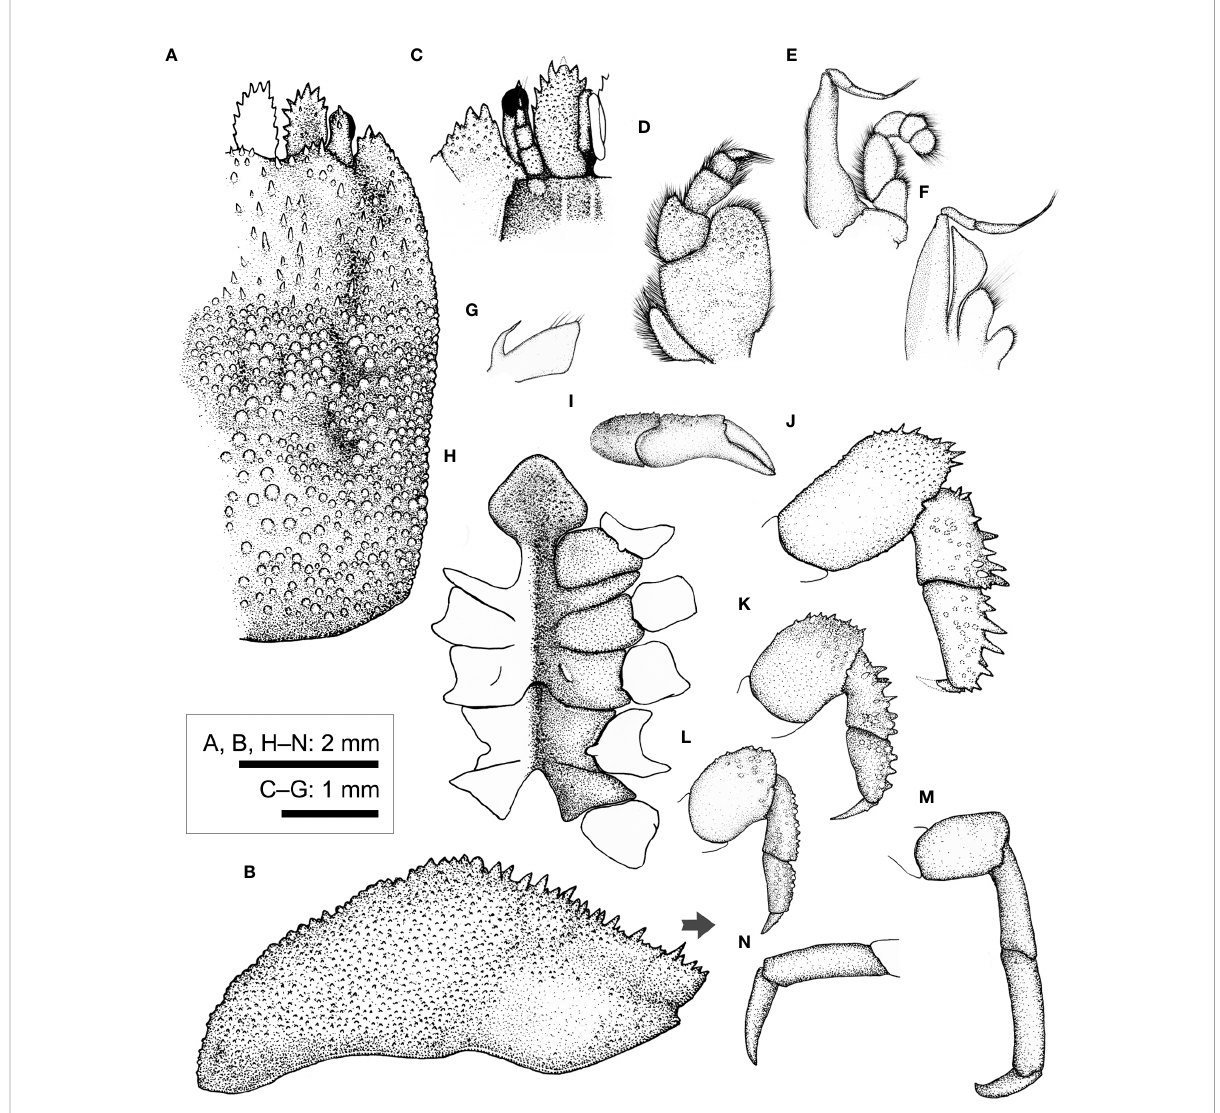
FIGURE 8 Cryptochirus coralliodytes Heller, 1860 (CEL-Hapa-022). (A) carapace, dorsal view; (B) carapace, lateral view; (C) anterior view of carapace, ventral view; (D) right Mxp3; (E) right Mxp2; (F) right Mxp1; (G) right Mxl 1; (H) thoracic sternites; (I) right P1; (J – M) right P2 to P5, dorsal view; (N) right P5, propodus and dactylus, lateral view. Arrow in (B) indicates the anterior